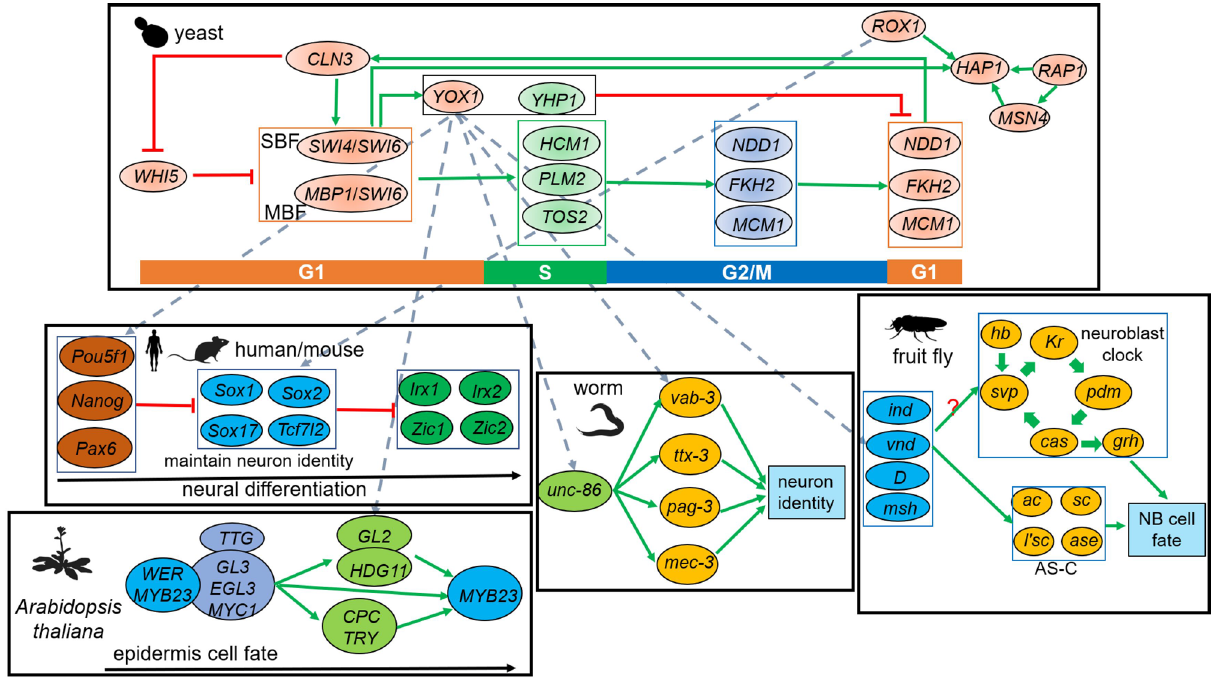
Figure 7. An integrated regulatory network model for the control of cell fate decision events during early stage of embryogenesis/cell cycle. This diagram depicts the regulatory interactions of cell fate determination occurring early embryogenesis/cell cycle. networks in black lined boxes represent regulatory interactions corresponding to each species. Transcription factors are denoted by ovals. Dashed grey lines represent orthologs. Green solid lines represent positive regulation and red lines represent negative regulation. Genes in colored boxes represent gene complexes/interactions. The question mark represents the regulatory relationship was unknown. AS-C achaete– scute